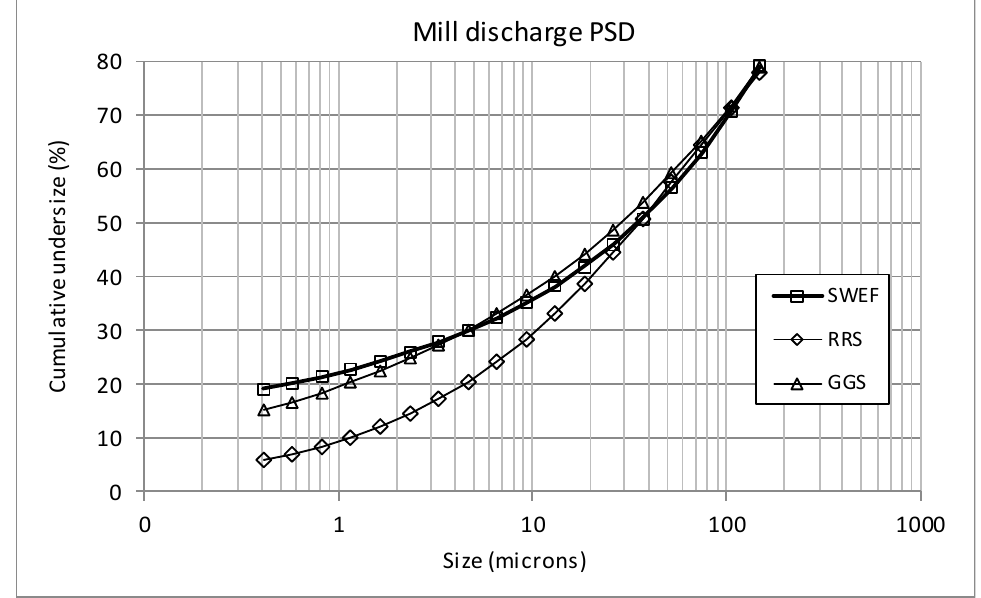
Figure 3. Particle size distribution simulated by the models under study.